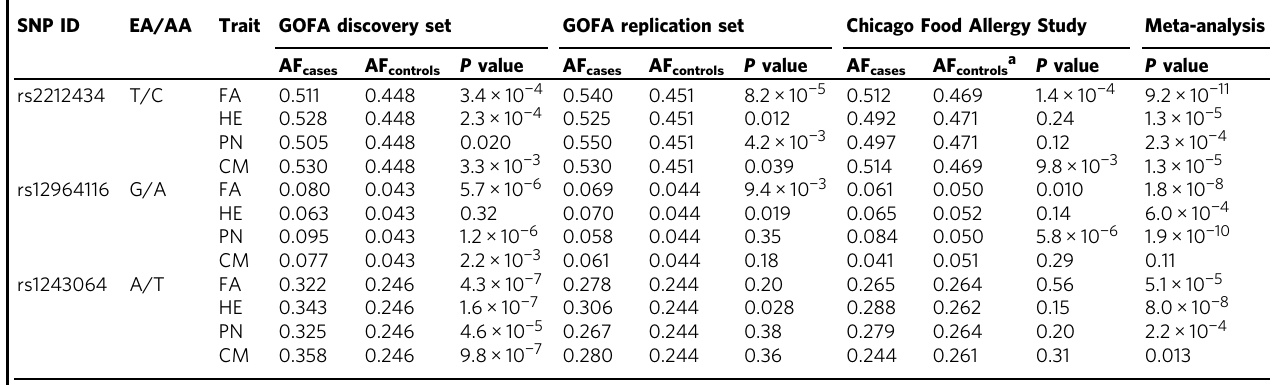
Table 4 Replication of C11orf30 / LRRC32 (rs2212434) and the clade B serpins gene cluster (rs12964116 and rs1243064) in the Chicago Food Allergy